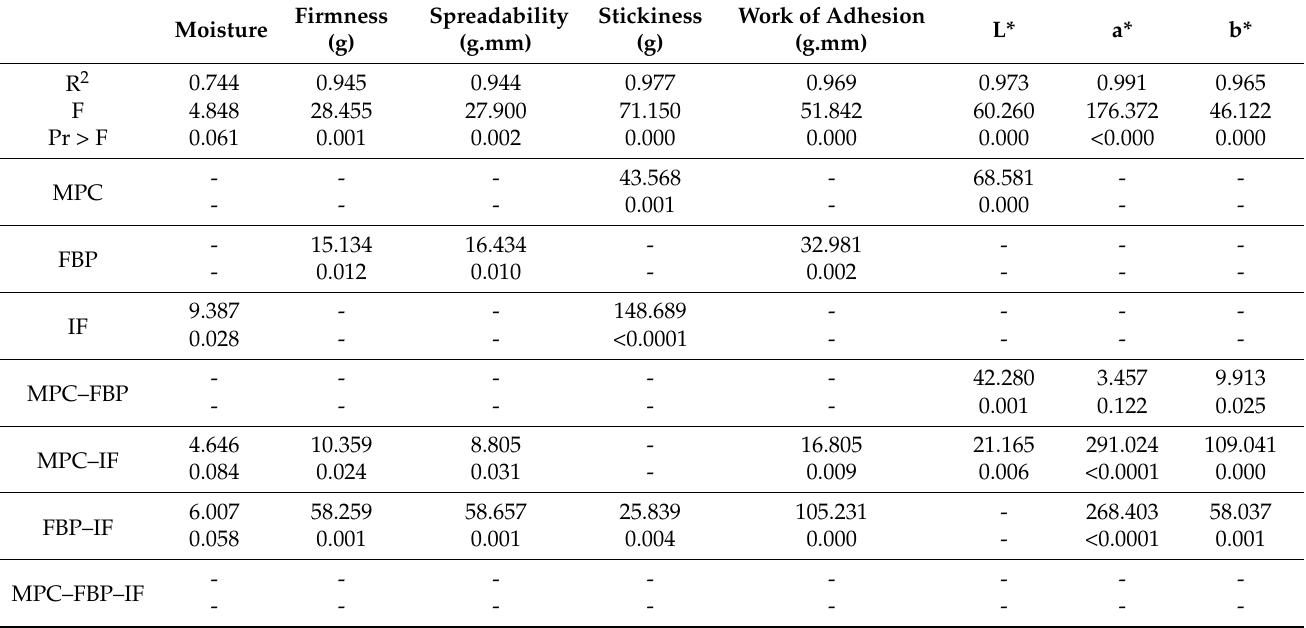
Table 6. Summary of statistics for the multiple linear regression, showing R-squared fit, F-value, and p -value for the model and each independent variable and their